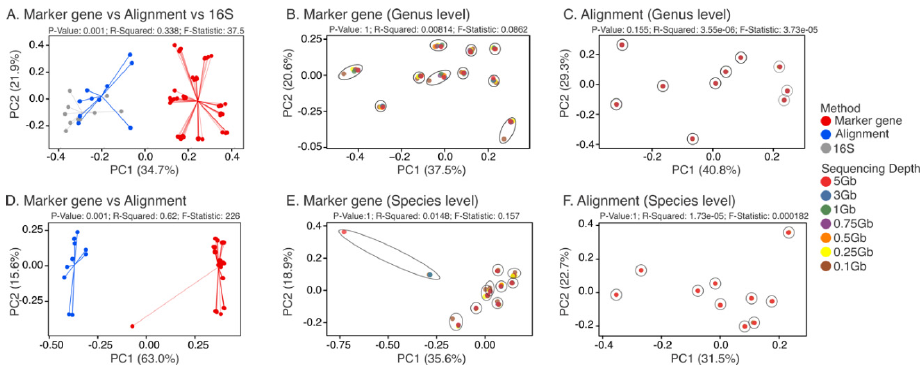
Figure 2. PCoA plots of the β -diversity (weighted Bray–Curtis distances) of ten stool samples from healthy subjects at various sequencing depths including 5 Gb (16.67 M reads), 3 Gb (10.00 M reads), 1 Gb (3.00 M reads), 0.75 Gb (2.50 M reads), 0.5 Gb (1.65 M reads), 0.25 Gb (0.85 M reads), and 0.1 Gb (0.34 M reads). The 16S rRNA (16S) V4 hypervariable region sequencing analysis at the genus level was performed for comparison. ( A ) SMS data annotated using the marker gene mapping and alignment methods, in comparison with the 16S sequencing information described above at the genus level. ( B ) SMS data annotated using the marker gene-mapping method at the genus level. ( C ) SMS data annotated using the alignment method at the genus level. ( D ) SMS data annotated using the marker gene mapping and alignment methods at the species level. ( E ) SMS data annotated using the marker gene-mapping method at the species level. ( F ) SMS data annotated using the alignment method at the species level. Clustering of data by subjects is highlighted using circles or